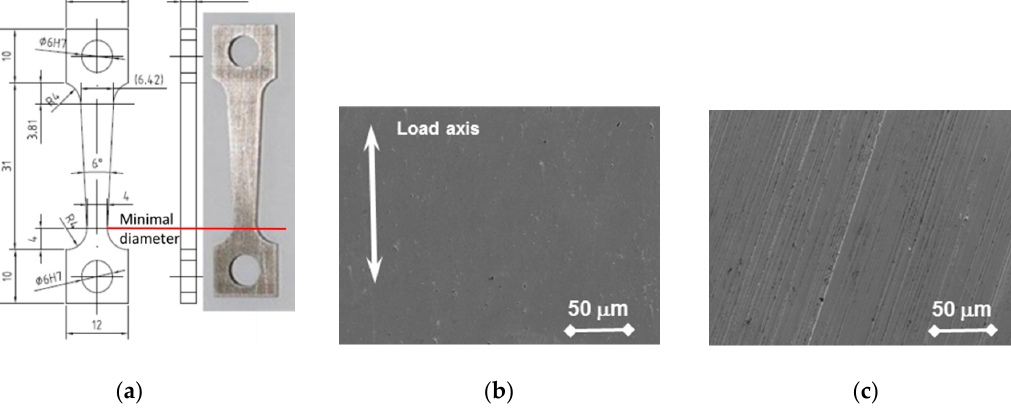
Figure 1. Tapered specimen: ( a ) Drawing, dimensions, and an image with a minimal diameter mark; ( b ) Polished (Ra = 0.005 μ m) and ( c ) ground (Ra = 0.047 μ m) surfaces before testing. Ra: arithmetical ( b ) Polished (Ra = 0.005 µ m) and ( c ) ground (Ra = 0.047 µ m) surfaces before testing. Ra: arithmetical mean roughness. mean